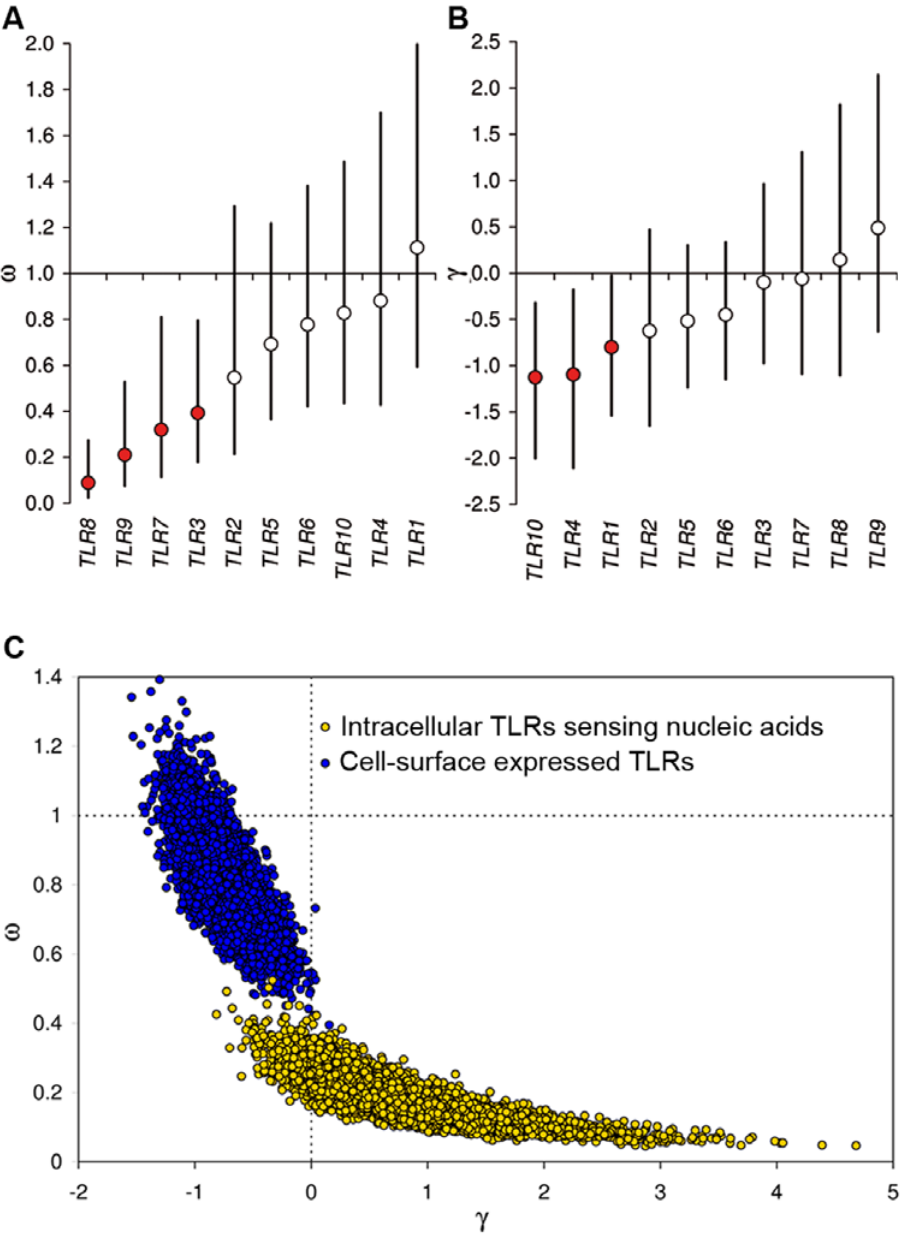
Figure 2. Estimation of the intensity of natural selection acting on individual TLR genes. (A) Strength of purifying selection acting on individual TLR genes, as measured by estimated v values. Bars indicate 95% CIs and red circles indicate genes with v estimates significantly lower than 1. (B) Strength of negative selection acting on individual TLR genes, as measured by the population selection coefficient c . Bars indicate 95% CIs, and red circles indicate genes with c estimates significantly lower than 0. (C) Joint estimates of the intensity of purifying ( v ) and negative ( c ) selection between intracellular nucleic acid sensors and cell-surface expressed TLRs.